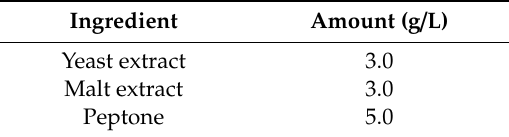
Table 3. Components of the modified YM